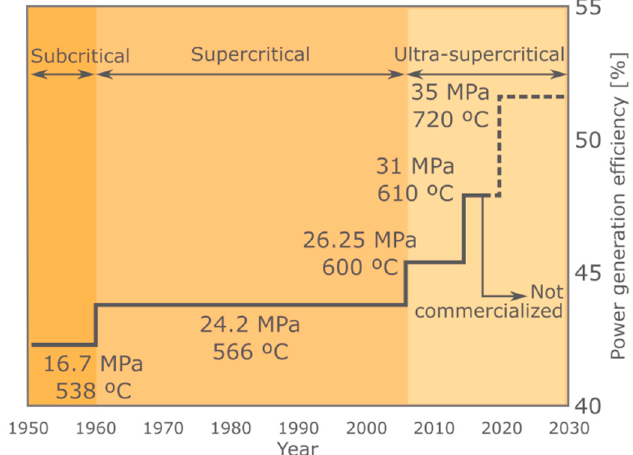
Figure 12. Evolution of capabilities of coal-fired power units in China (adapted from